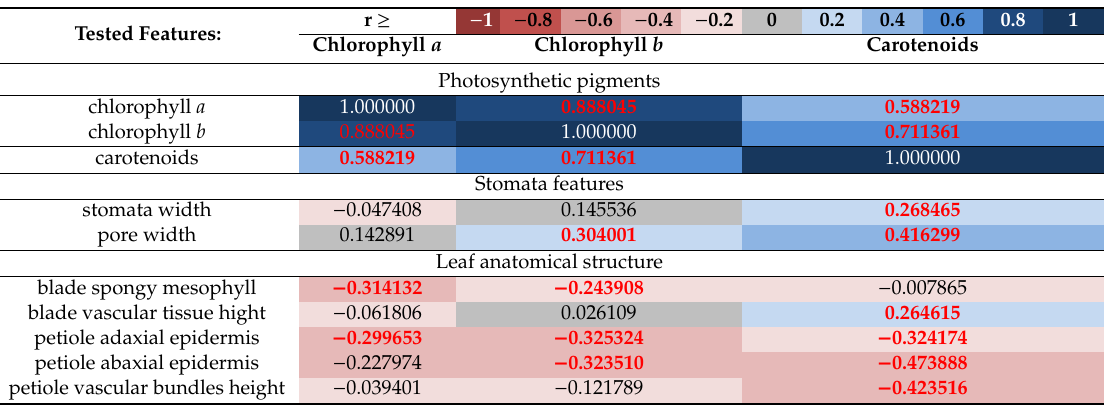
Table 3. Map of the correlations between the level of photosynthetic pigments and other investigated parameters of gerbera leaves grown under di ff erent qualities of LED light and in the media with di ff erent concentrations of